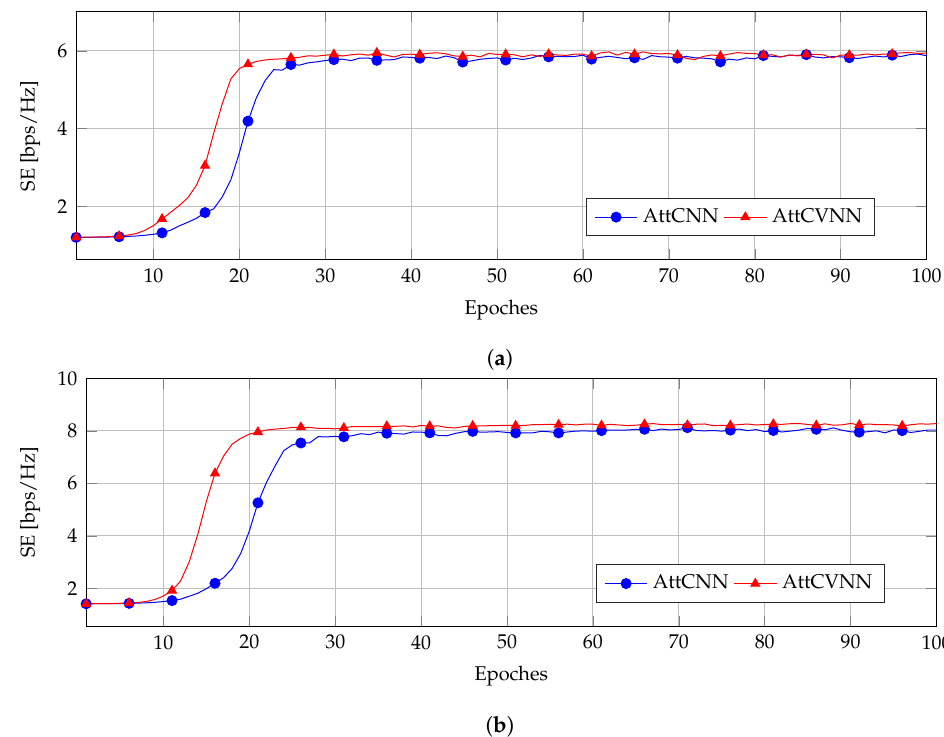
Figure 5. Convergence rate for the configuration INR = 40 dB: ( a ) SNR PB = 60 dB; ( b ) SNR PB = 50